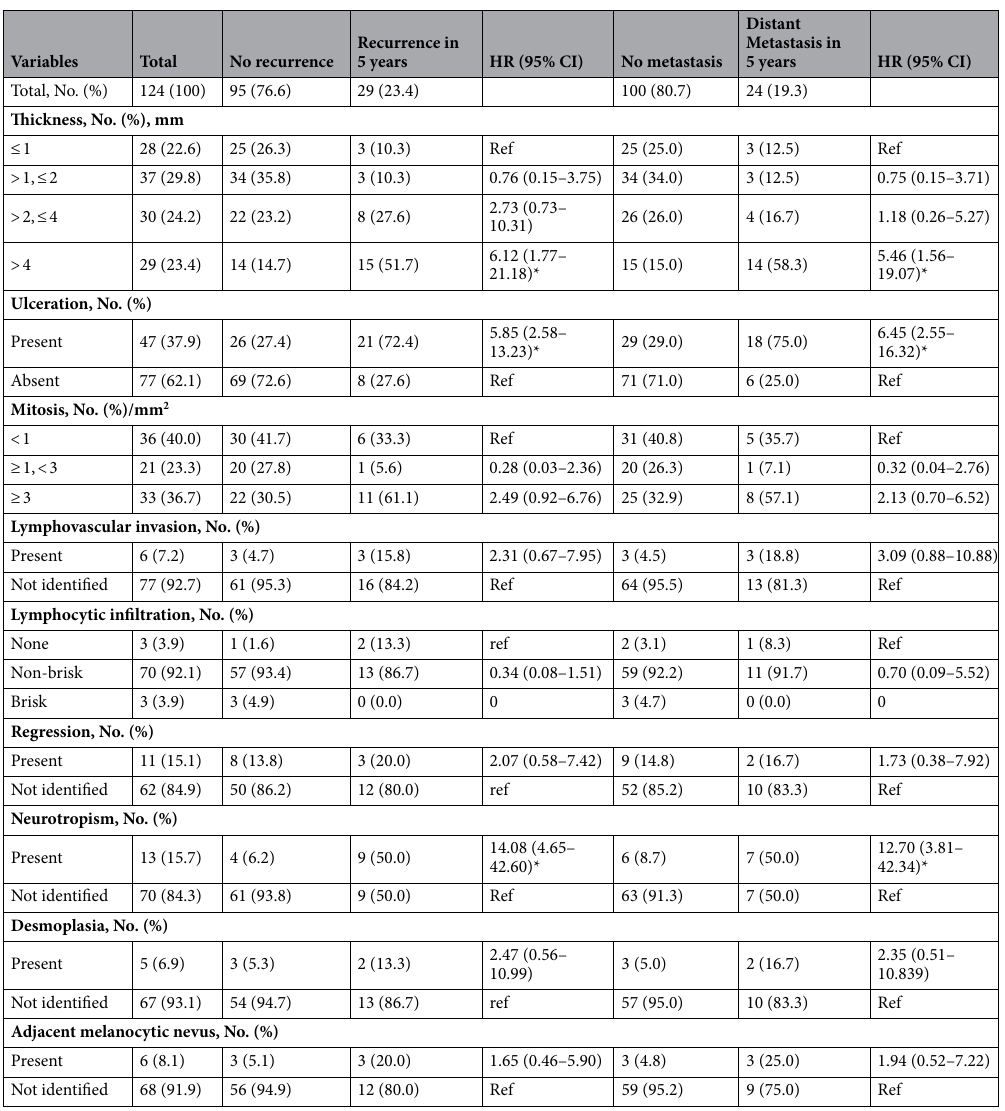
Table 3. Pathological risk factors of recurrence and distant metastases in 5 years among ALM patients. ALM acral lentiginous melanoma, HR hazard ratio, CI confidence interval. *Statistically significant with 95% CIs not including